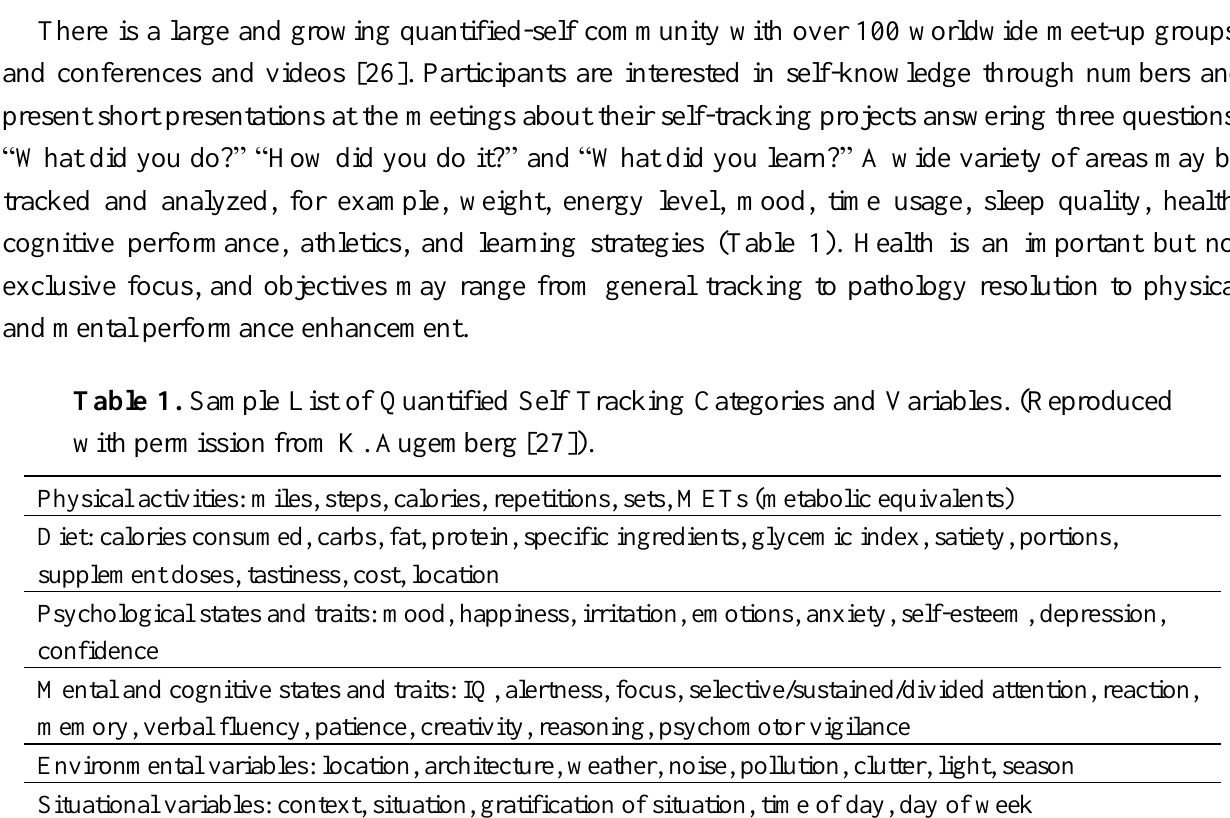
Figure 3. Examples of Quantified Self Devices: Withings Pulse sleep monitor and the Vital Connect Health Patch [24,25].